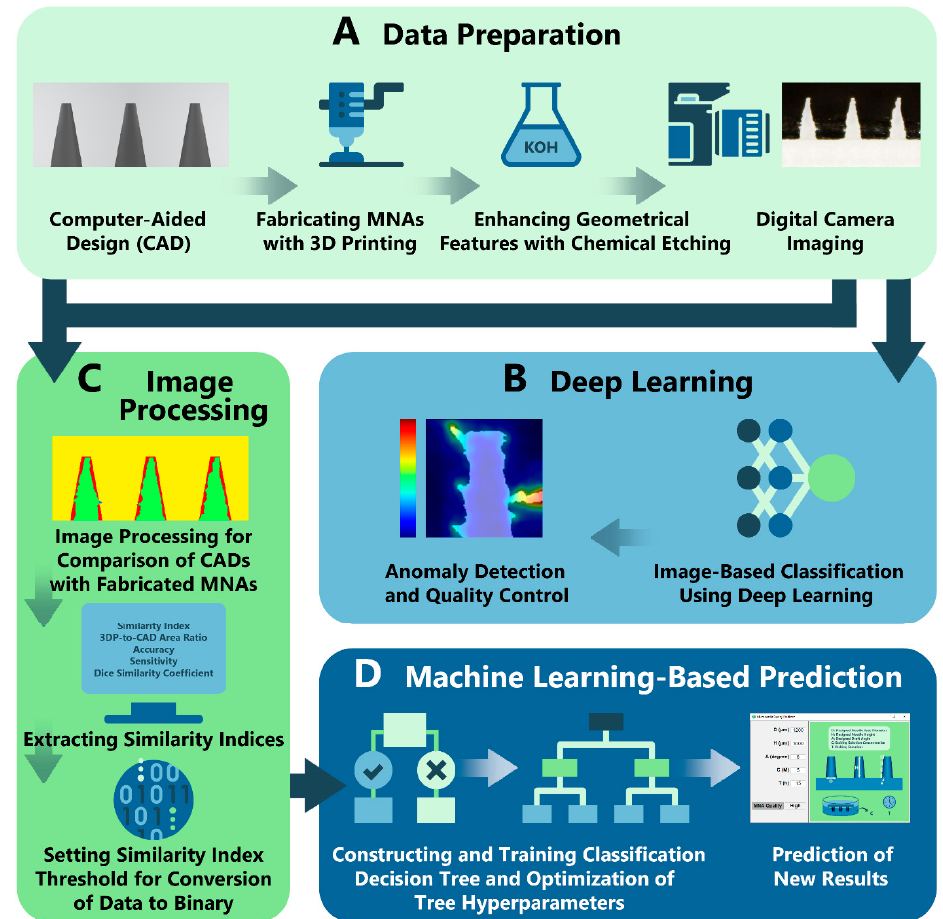
Figure 2. Workflow of preparing and processing data for AI models. ( A ) Based on design and fabrication criteria, a total of 240 MNA instances were possible. Each instance was imaged with a digital camera. ( B ) The captured MNA photos were automatically separated and binarized to a dataset of 2400 MN photos, which were analyzed for their quality and anomaly detection using DL. ( C ) For comparison of original designs and the fabricated MNAs, instances were processed for extraction of five different similarity metrics. ML models were developed by receiving five input parameters (three design features: base diameter, height and drafting angle of MNs; and two etching features: etching solution concentration and etching duration). ( D ) A classification tree was constructed to optimize the hyperparameters (maximum number of splits and split criterion), and then it was trained for classification. Finally, the trained model was used to predict the quality of the resulting MNA for the criteria defined by user.